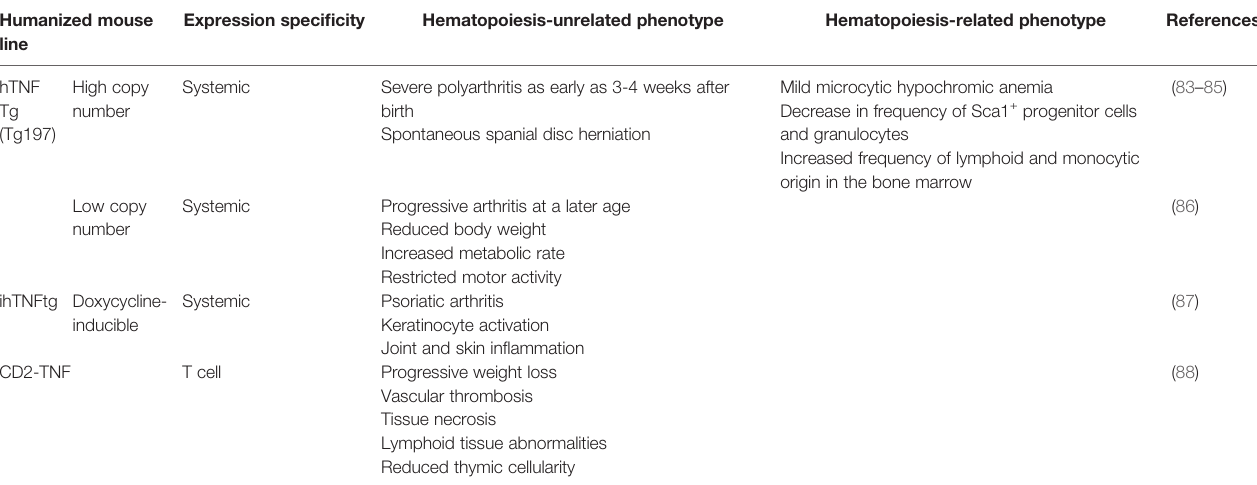
TABLE 2 | Humanization of TNF/LT system in mice as a tool to study human hematopoiesis. Humanized mouse